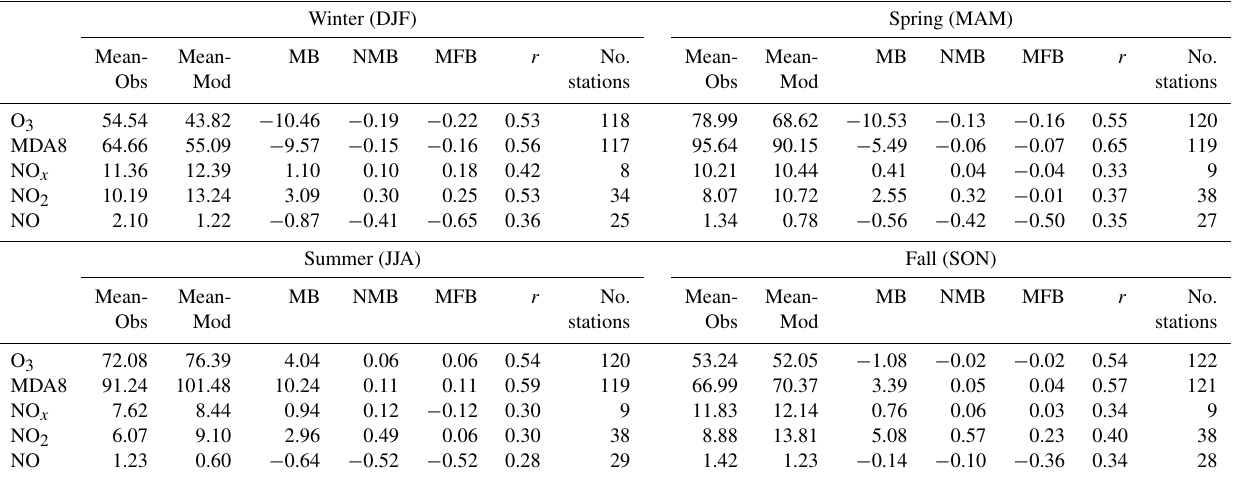
Table 6. Statistics for MOZART simulation against hourly observations from the EMEP network. Means and MB are expressed in µgm − 3 ; NMB, MFB, and r are unitless. r is the hourly temporal correlation coefficient for all quantities except MDA8, for which it represents the daily temporal correlation coefficient.